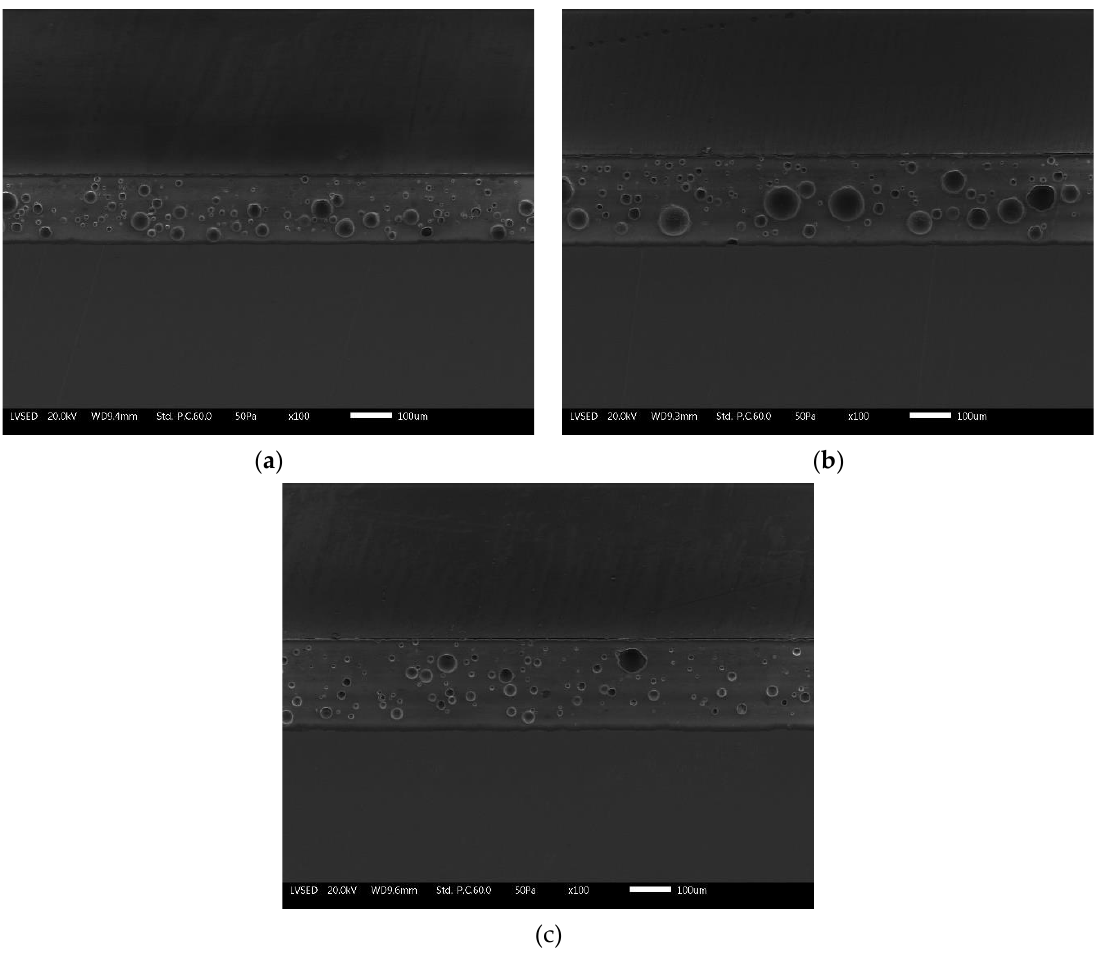
Figure 4. SEM cross-sectional micrographs of ( a ) reference sample E0, ( b ) sample E1, and ( c ) sample E2.